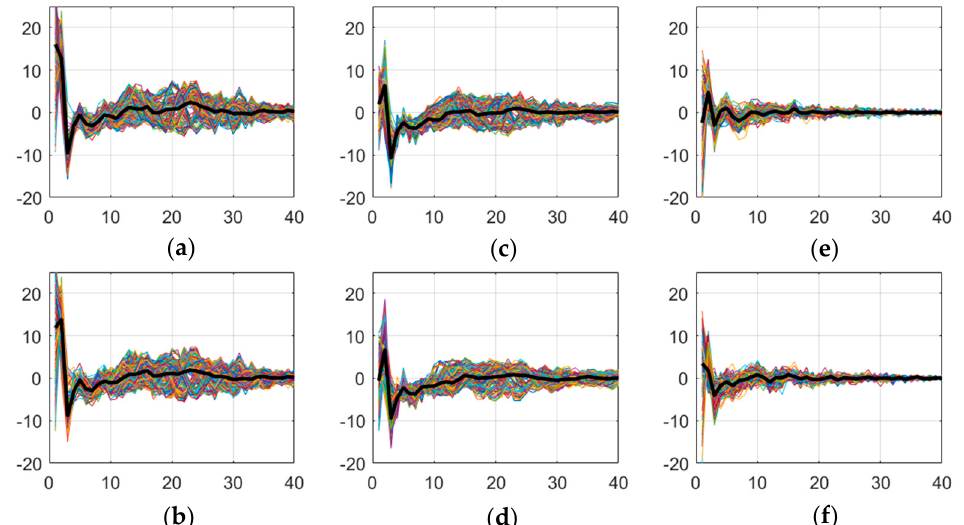
Figure 5. Features of two violins: ( a ) mel-frequency cepstral coefficients (MFCC) of violin A; ( b ) MFCC of violin B; ( c ) Tonal GFCC of violin A; ( d ) tonal GFCC of violin B; ( e ) nontonal GFCC of violin A; ( f ) nontonal GFCC of violin B.